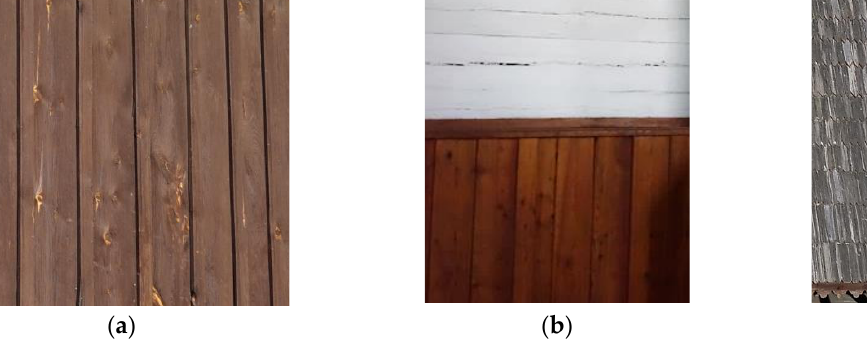
Figure 8. Identification of objects on photos: ( a ) formwork material, ( b ) walls, ( c ) architectural details roof with a crack.